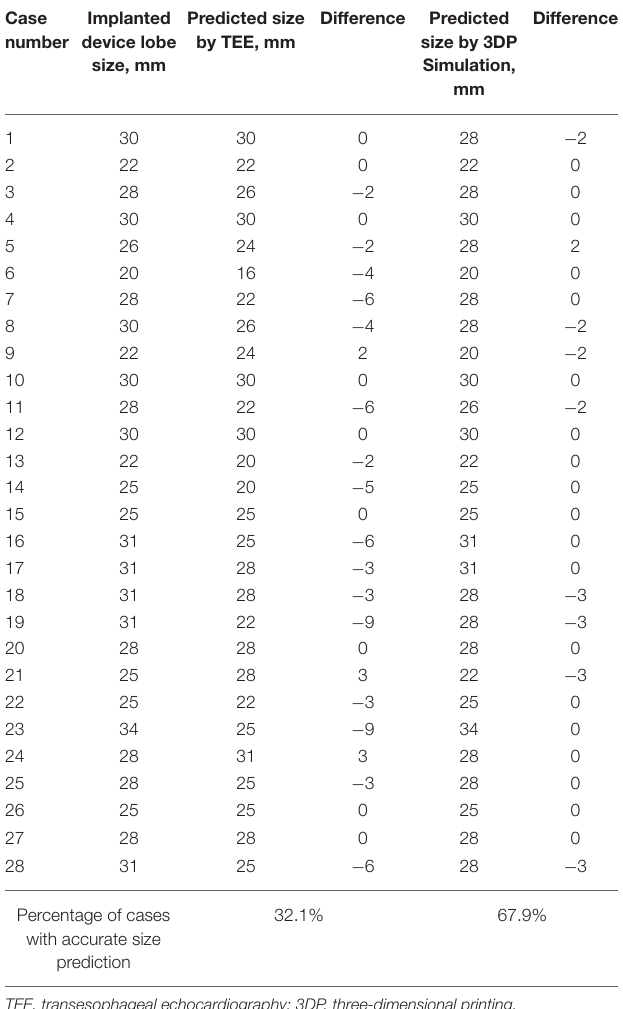
TABLE 3 | Predicted and implanted left atrial appendage occluder device sizes. Case Implanted number device